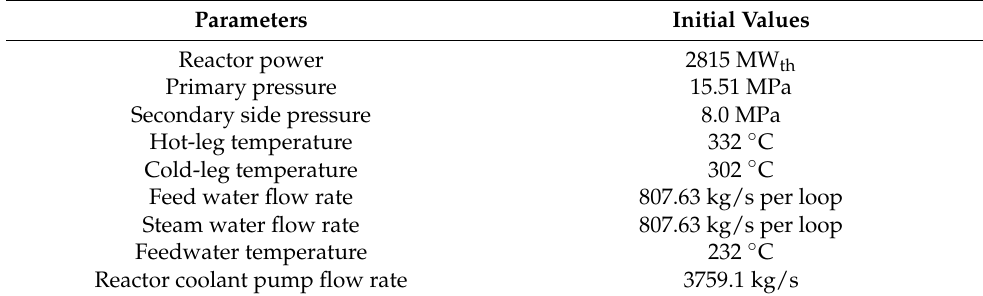
Table 3. Initial conditions for thermal-hydraulic